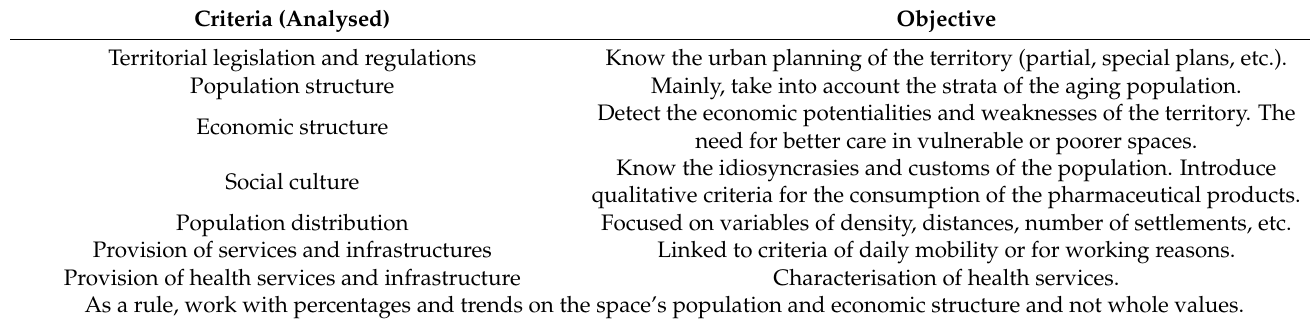
Table 4. Basic criteria followed for the preparation of the expert report on the proposed relocation of a pharmacy in Galicia